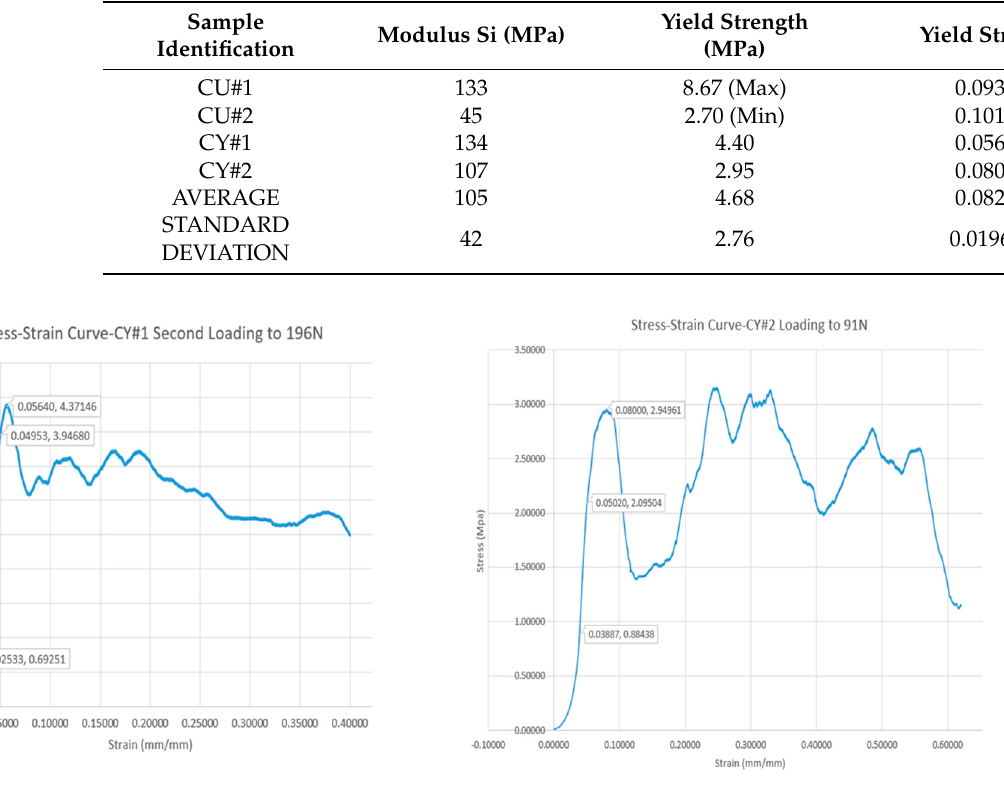
Figure 5. Stress–strain curves for cylinder bone samples 1 and 2.